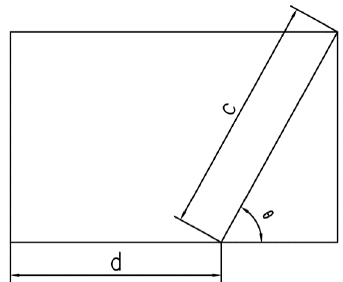
Figure 5. Planform of a honeycomb unit.